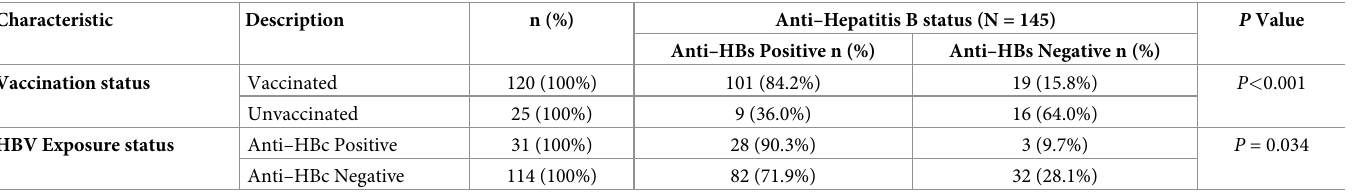
Table 2. Anti–HBs response based on vaccination and HBV exposure status among HCW at KNH, Mbagathi County and Naivasha sub-county hospitals.